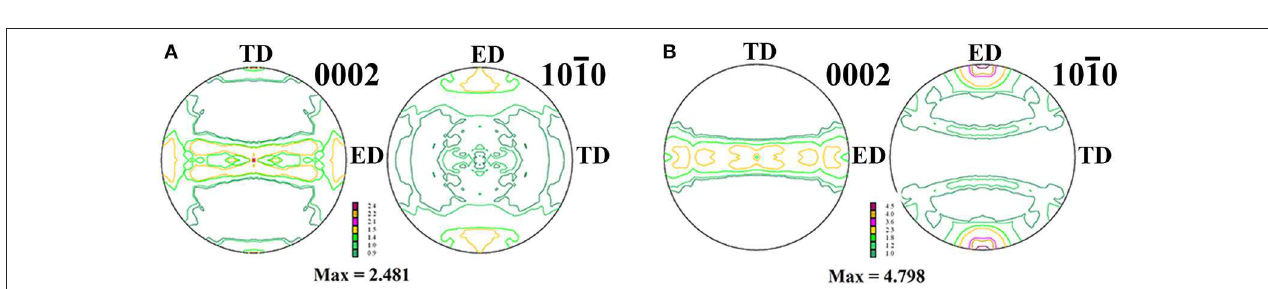
FIGURE 2 | X-ray diffraction patterns of (A) as-extruded Mg − 1Sn alloys and (B) as-extruded Mg − 1Sn − 0.1Ti alloys.